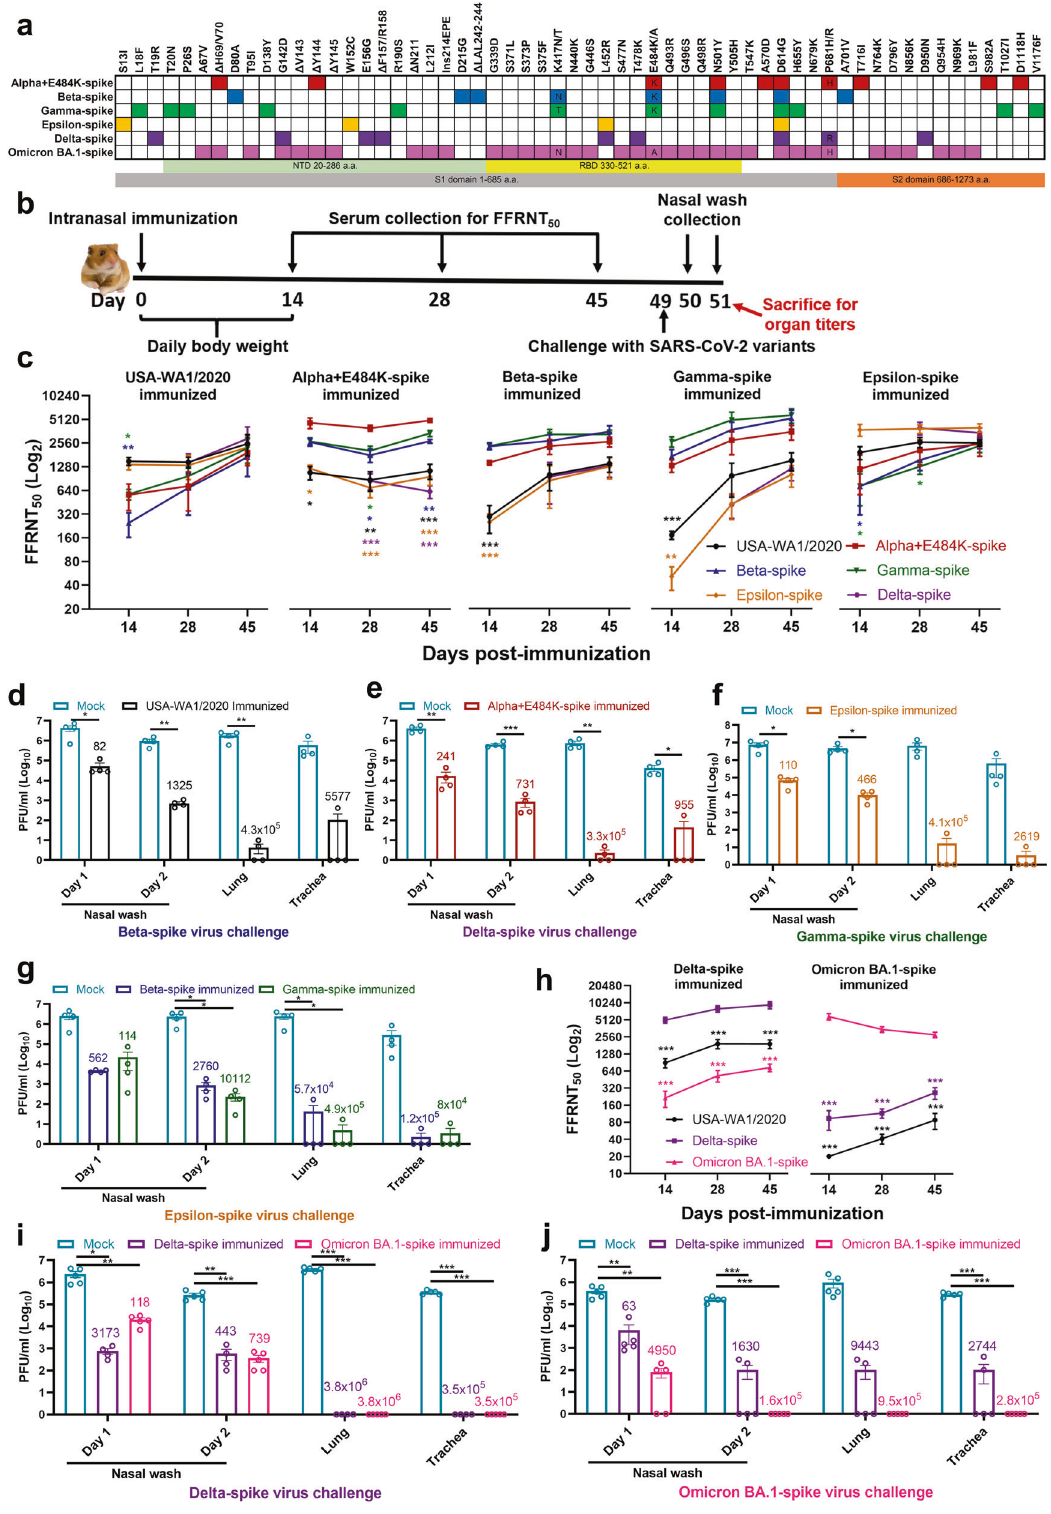
developed more weight loss (Supplementary Fig 6a) and diseases (Supplementary Fig 6b) than the Omicron BA.1-spike virus- inoculated hamsters. The results are in agreement with the recent reports that Omicron causes milder disease in hamsters 5 and humans. 6